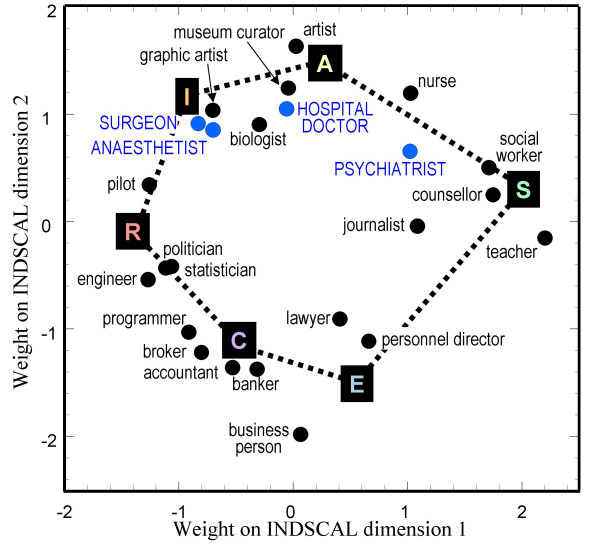
INDSCAL group space of the career preferences expressed by the general population sample. The locations of the labels R, I, A, S, E and C are approximate and are only for guidance and orientation. The four medical specialities are shown in blue so that they are more visible.